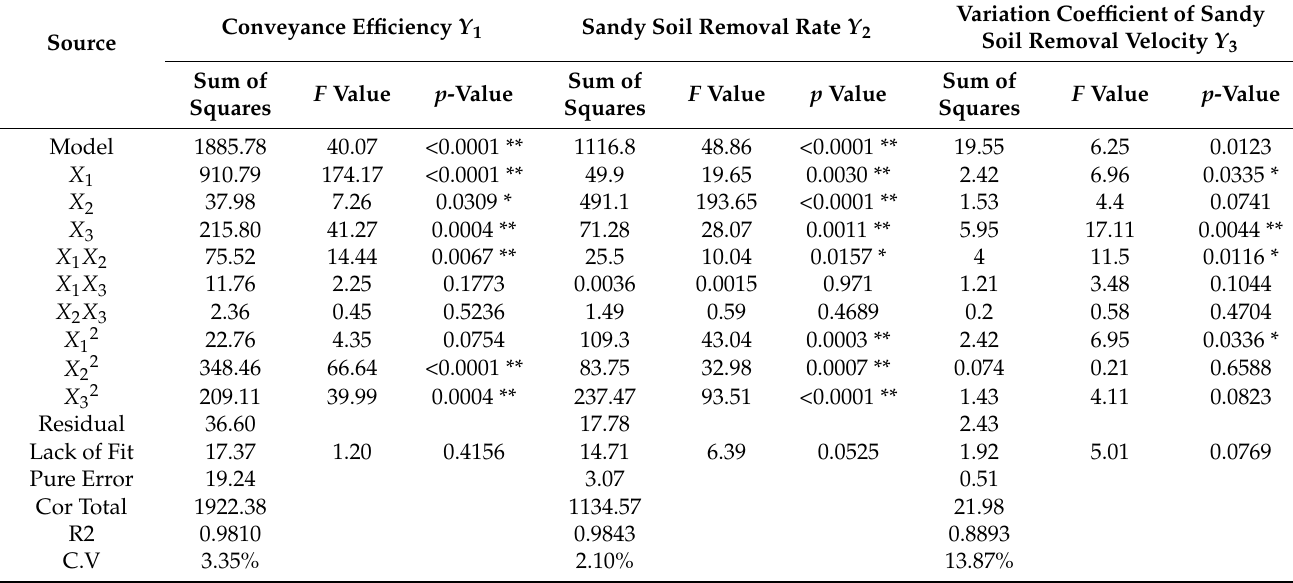
Table 5. Variance analysis results of response surface